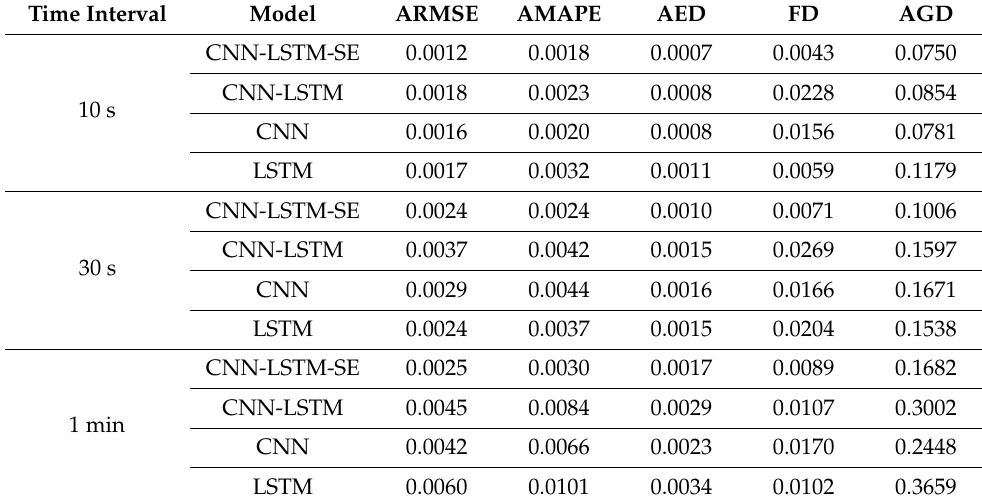
Table 3. Trajectory prediction results of ship-2.